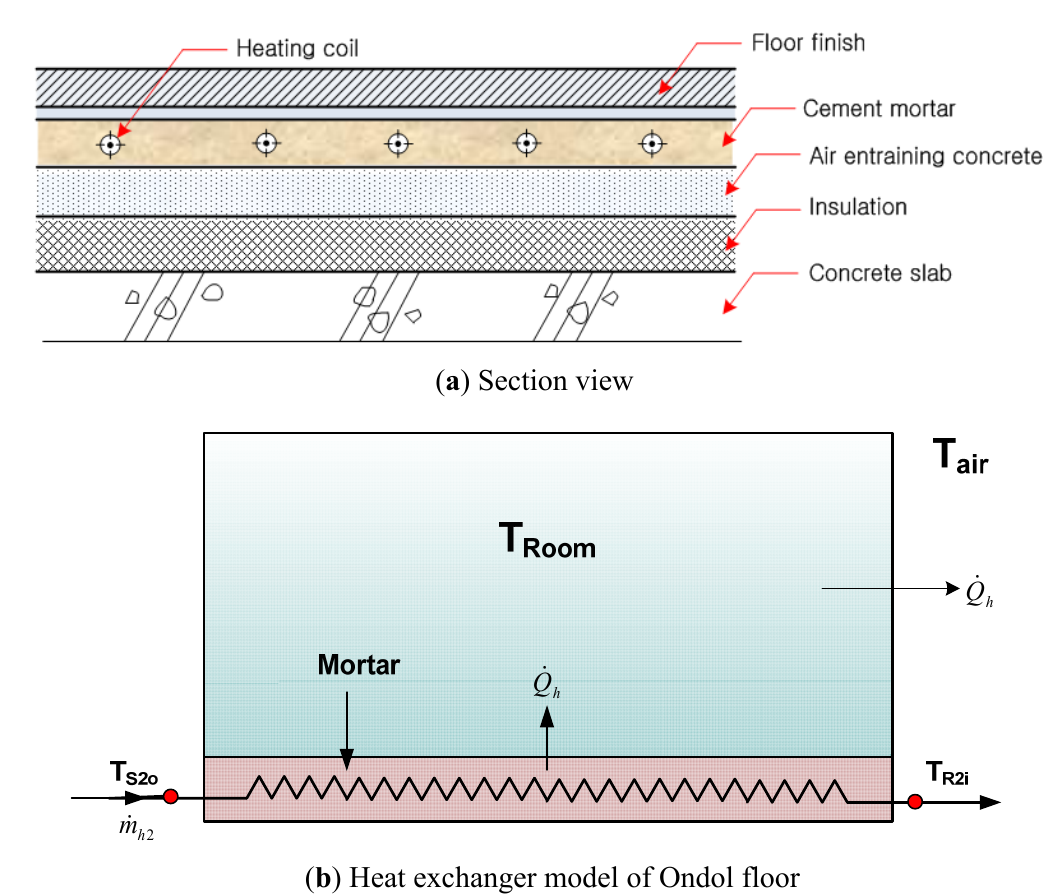
Figure 11. Traditional Korean Ondol floor heating